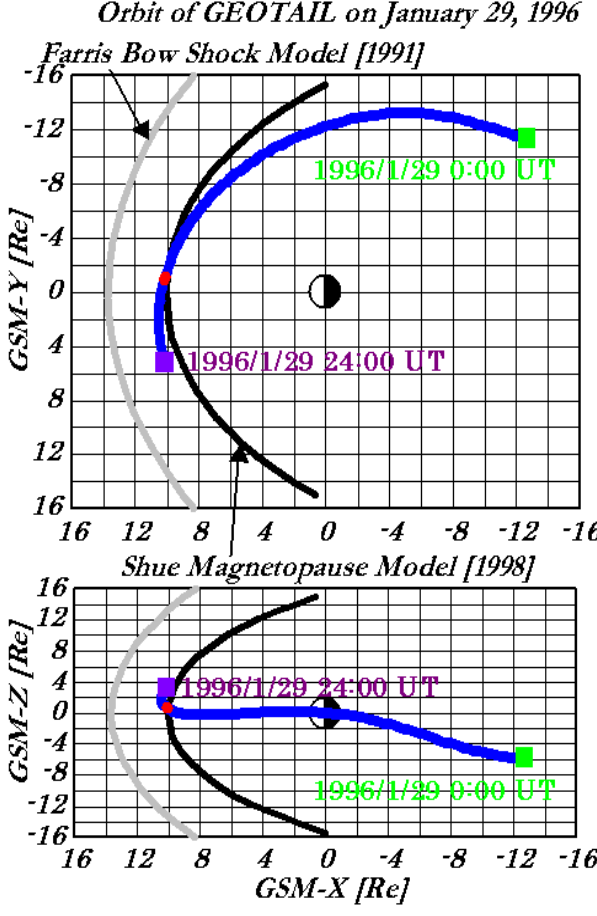
Fig. 2. The orbit of GEOTAIL on 29 January 1996 projected onto the GSM-X and -Y (upper) and GSM-X and -Z (lower) planes. The start (00:00 UT) and end (24:00 UT) points of the trajectory are marked by green and purple solid boxes, respectively. The loca- tions where GEOTAIL crossed the MPCL/LLBL are marked by red points. The gray and black curves show the model bow shock (Far- ris et al., 1991) and magnetopause (Shue et al., 1998), respectively.